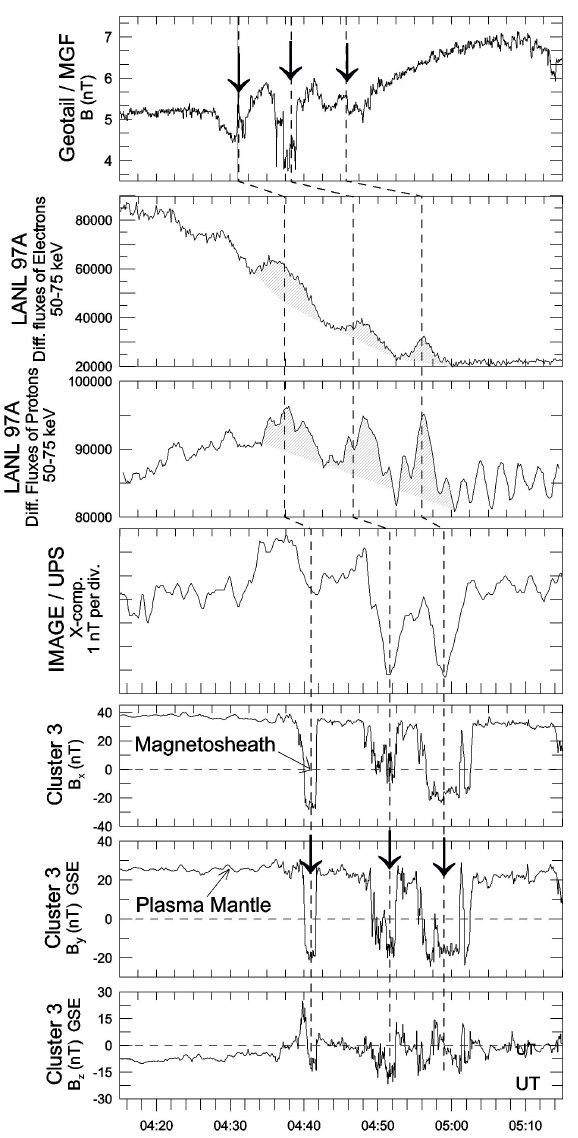
Fig. 5. From top to bottom, Geotail/MGF solar wind magnetic field magnitude, LANL 97A differential fluxes of energetic (50–75keV) electrons and ions inside the magnetosphere, IMAGE UPS sta- tion X-component magnetogram on the Earth’s surface, and Clus- ter 3 magnetic field measurements (B x ,B y and B z components) at the plasma mantle/magnetosheath region, are shown. The magne- tosheath proper is characterized by negative B y values, while the vertical dashed lines mark the different arrival times of signals pro- duced by solar wind pressure variations at different places.